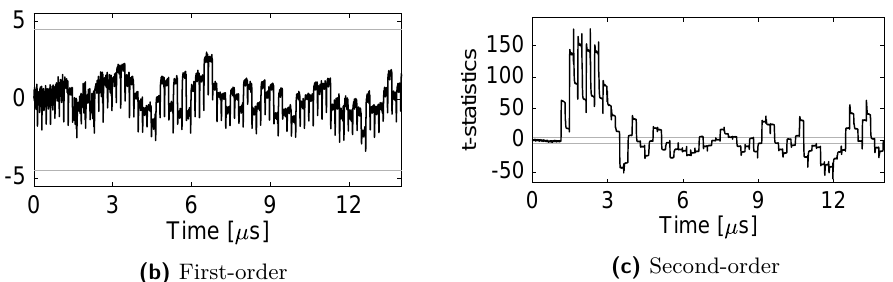
Figure 7: Experimental analysis of our first-order PRESENT round-based encryption design (covering the entire encryption); fixed vs. random t-test results using 100 million